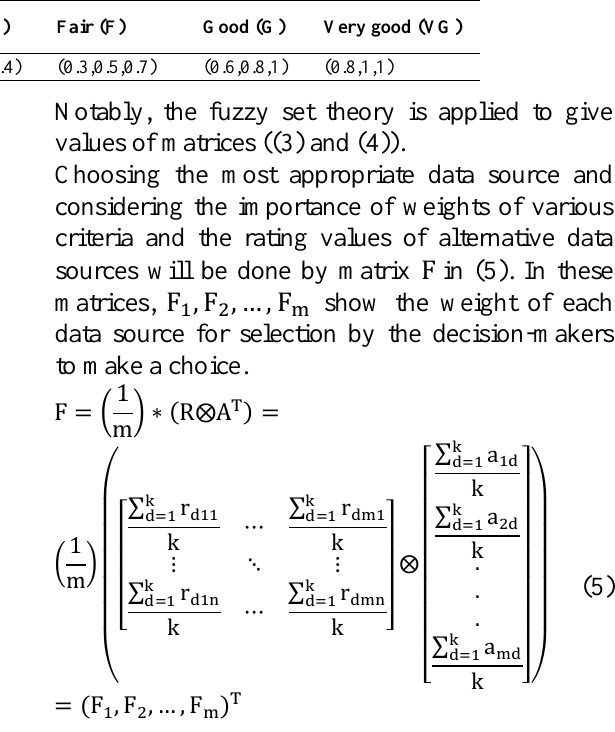
Table 2. Linguistic terms for